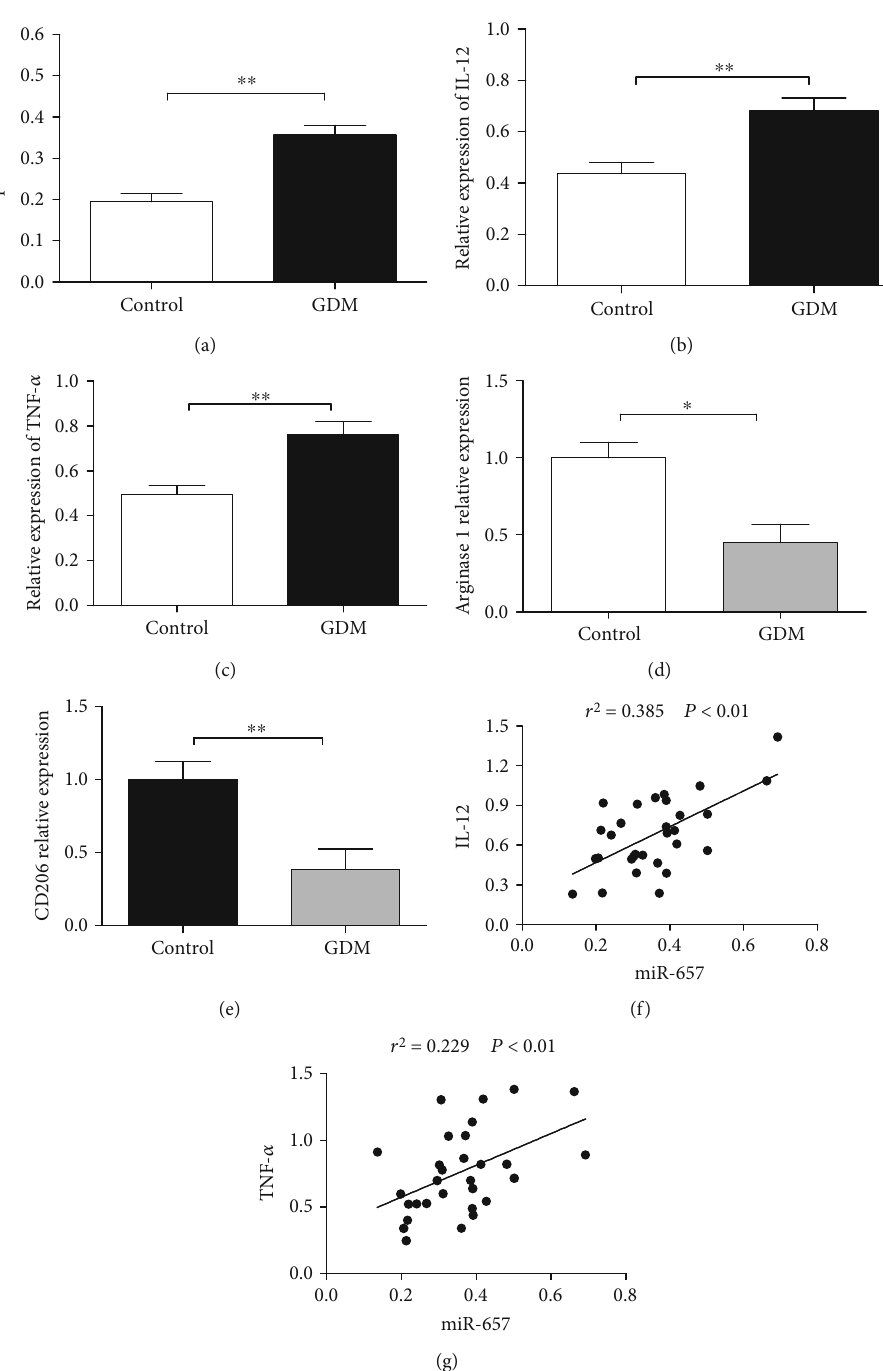
Figure 1: miR-657 is increased and positively associated with M1 markers of placental macrophages in GDM. (a) Increased expression of miR-657 in GDM placental macrophages compared with controls ( ∗∗ P < 0 : 01 ; N / N , 30/29). (b) mRNA level of IL-12 in GDM placental macrophages in contrast to normal controls ( ∗∗ P < 0 : 01 ; N / N , 30/29). (c) mRNA level of TNF- α in GDM placental macrophages compared with normal pregnancies ( ∗∗ P < 0 : 01 ; N / N , 30/29). (d) mRNA level of Arginase 1 in placental macrophages of GDM pregnancies in contrast to controls ( ∗ P < 0 : 05 ; N / N , 30/29). (e) mRNA level of CD206 in placental macrophages of GDM pregnancies compared with controls ( ∗∗ P < 0 : 01 ; N / N , 30/29). (f) Positive association between miR-657 and IL-12 in GDM placental macrophages ( N = 30 ). (g) Positive association between miR-657 and TNF- α in GDM placental macrophages ( N = 30